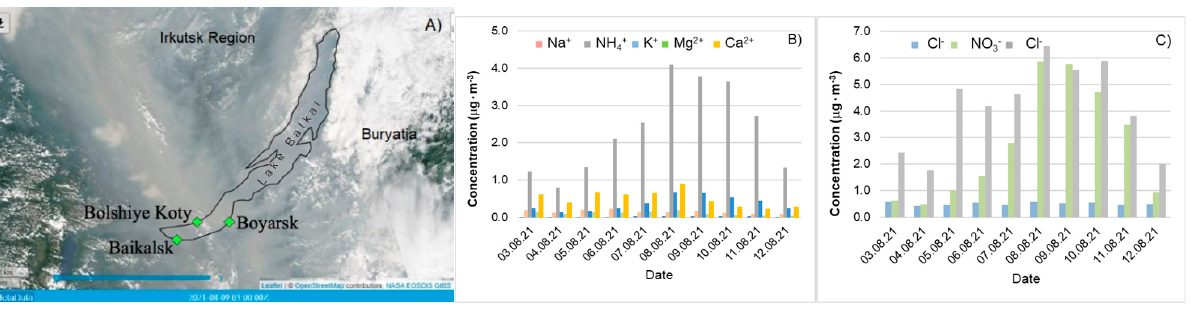
Table 4. Ionic composition of the atmospheric aerosol at the Bolshiye Koty research station from 2002 to 2021, μ g/m 3 (the upper line shows the arithmetic mean ± standard deviation; the lower line shows the range).